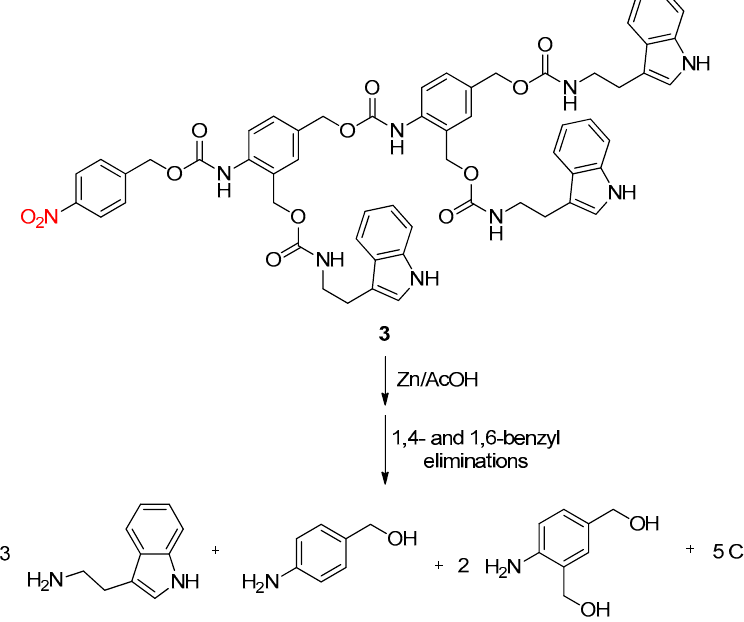
Scheme 3. Elimination of two paclitaxel molecules in a single triggering nitro reduction of com- pound 2